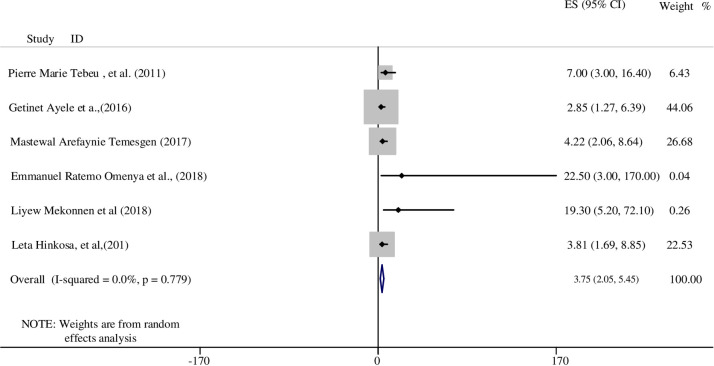
The association between previous HDP and HDP in SSA.